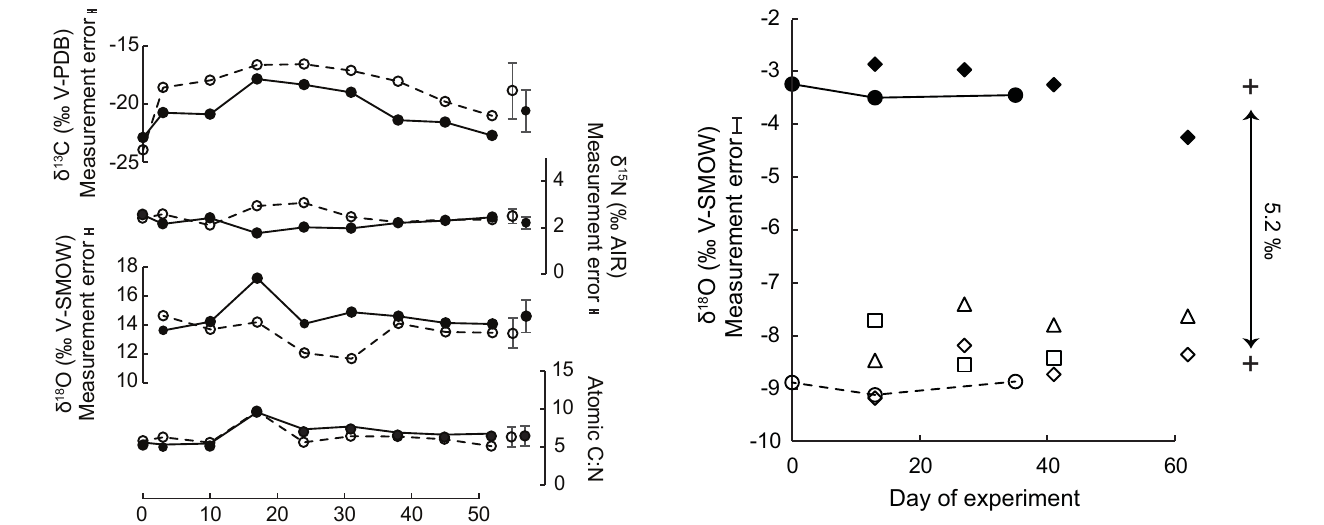
Figure 2. δ 18 O values of the water in the storage barrels for the standard water (open circles, dashed line) and the artificially 18 O- enriched water (closed circles, solid line) sampled on day 0, 13 and 35; and the δ 18 O values of the water sampled from the experi- mental jars before water was exchanged for Treatment 1 (open dia- monds, control), Treatment 2 (open triangles, 13 C-depleted algae), and Treatment 3 (closed diamonds, 18 O-enriched water) sampled on day 13, 27, 41 and 62; and Treatment 4 (open squares, 20 ◦ C) sam- pled on day 13, 27 and 41. The plus symbols ( + ) on the right side indicate the mean of the mean experimental jar values and the mean storage barrel values for the standard water and the 18 O-enriched water,